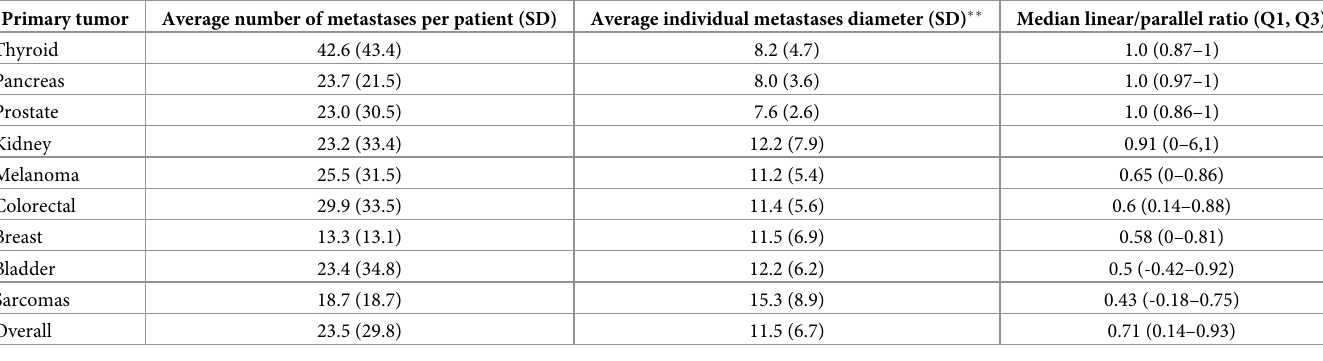
Table 1. Measurements of the metastases and their linear/parallel ratio